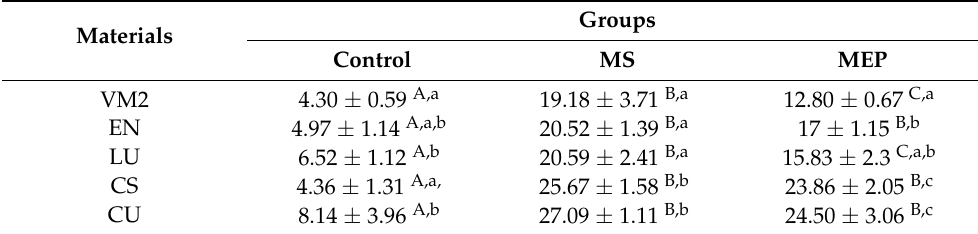
Same upper case superscript letters within a row indicates mean values with no statistically significant difference ( p > 0.05). Same lower case superscript letters within a column indicates mean values with no statistically